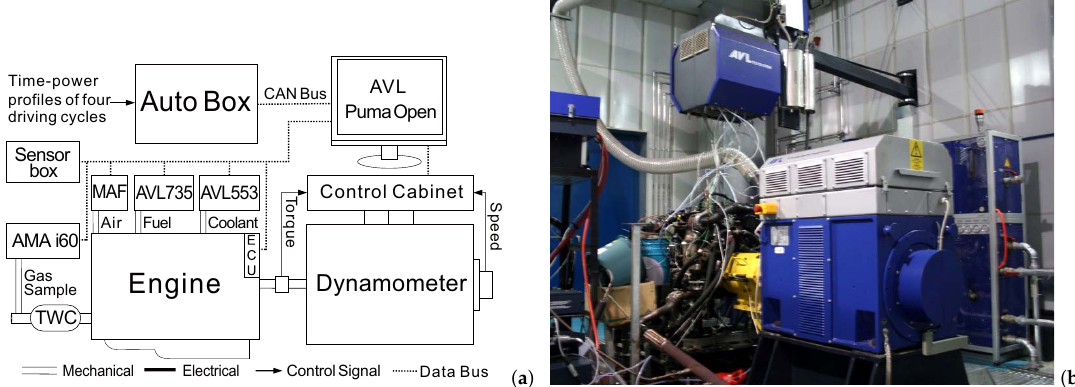
Figure 8. Schematic diagram and photo of the experimental bench. ( a ) Schematic diagram of the experimental bench; and ( b ) photo of the experimental